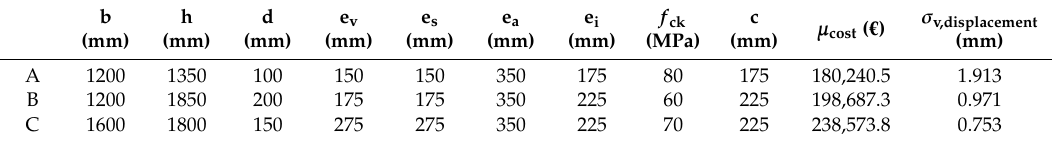
Table 9. Comparison of di ff erent designs of the Pareto Frontier with a 20% variation of the overload.